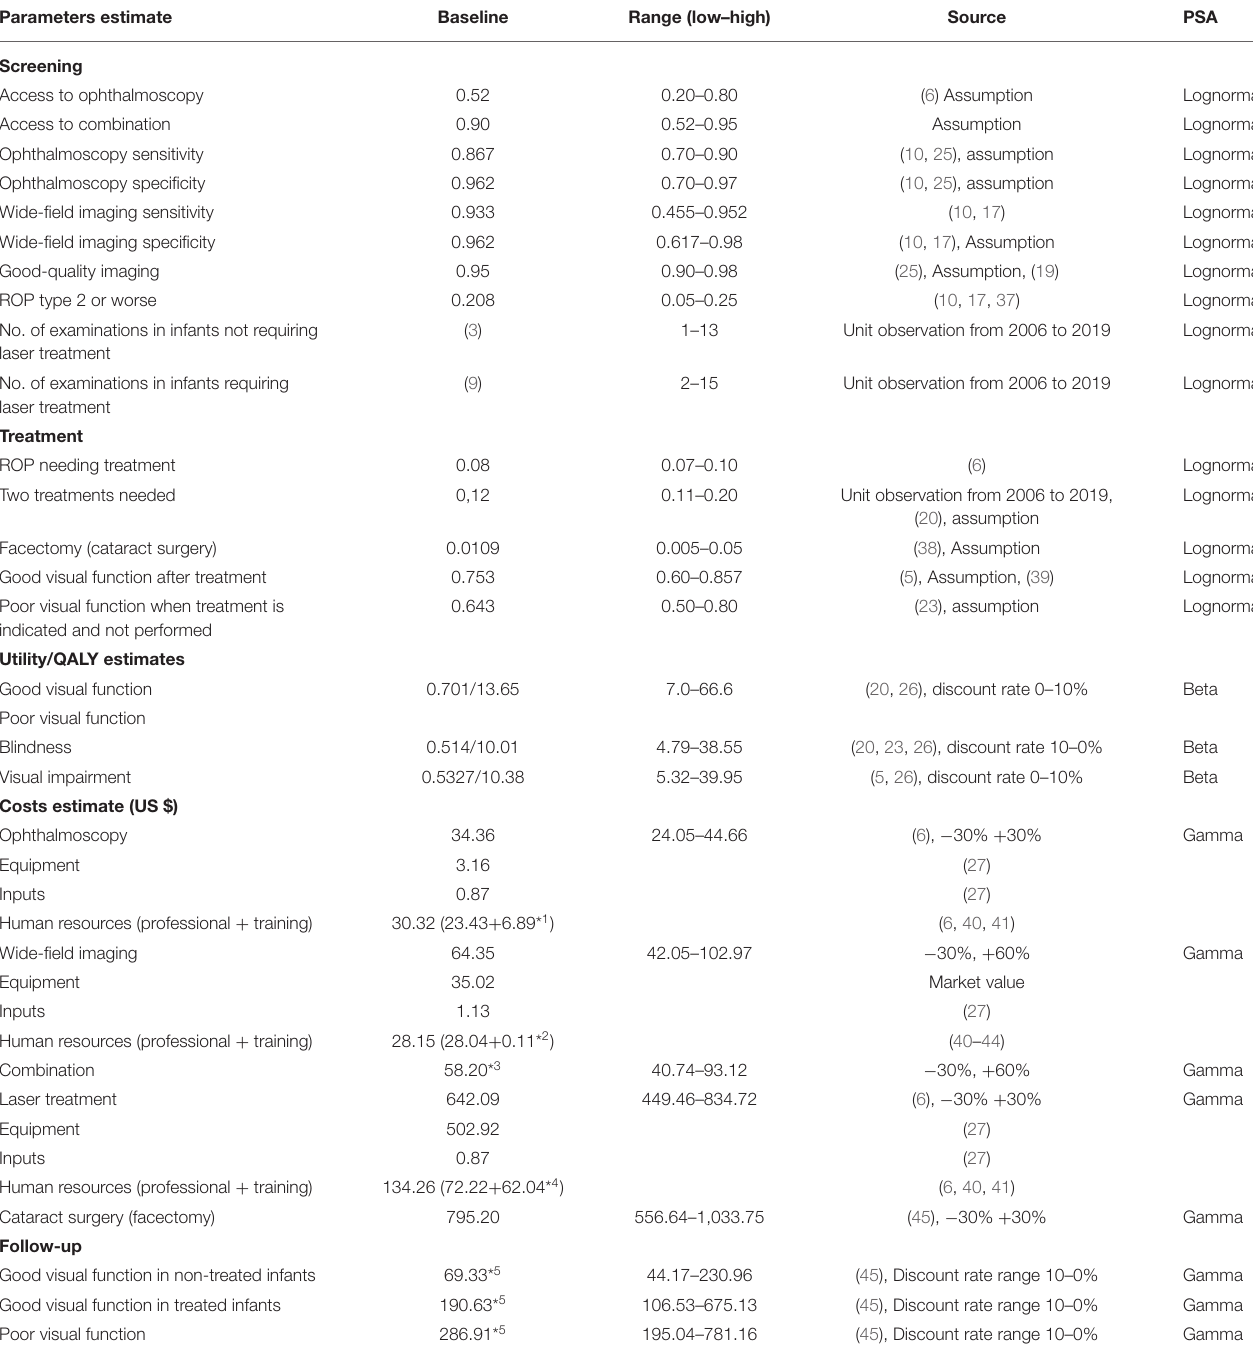
TABLE 1 | Parameter estimates used in the model divided by screening, treatment, and follow-up categories. Parameters